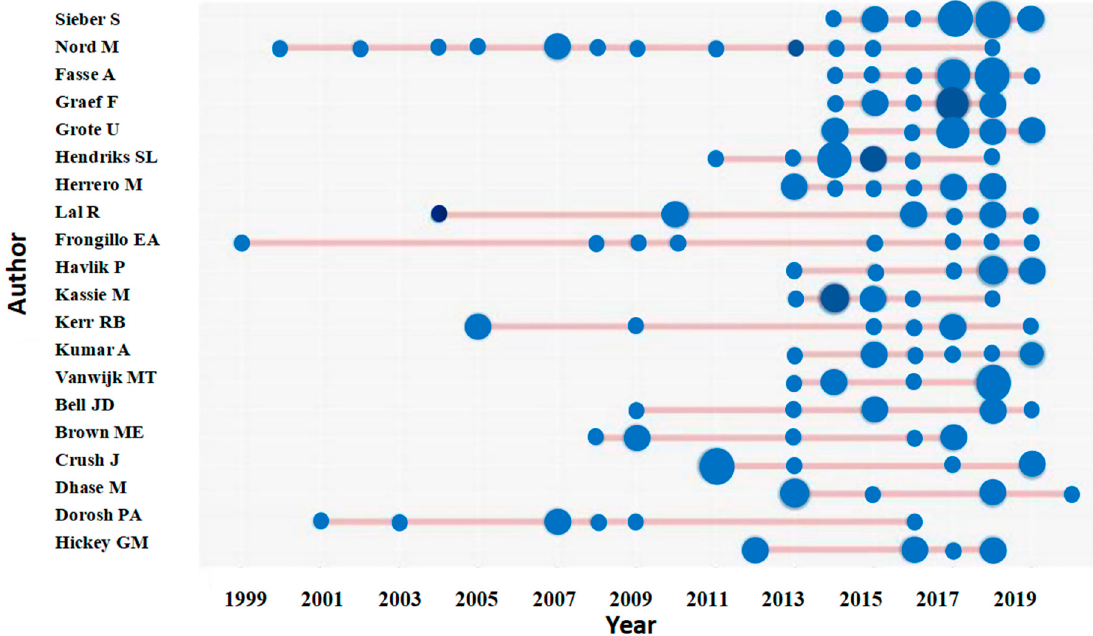
Figure 3. Authors’ production over time in the field of food